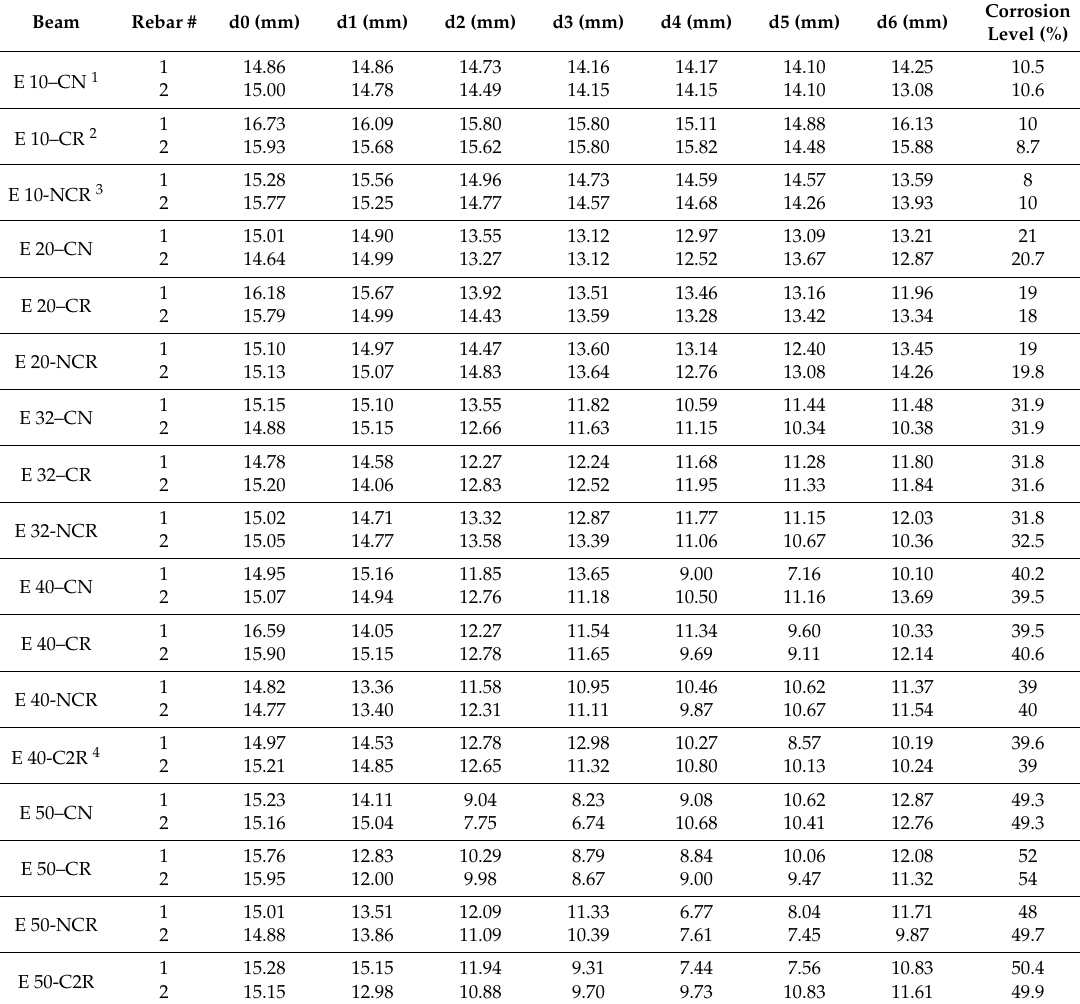
Table 2. Rebar diameter schedule for different corrosion levels. E: Experimental.